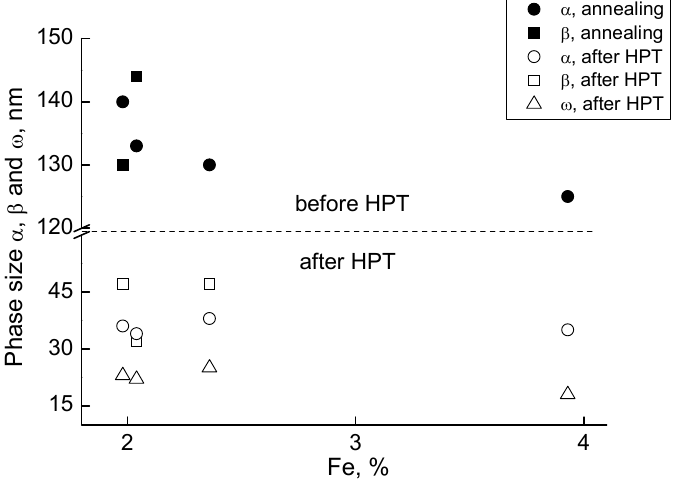
°C, 270 h, quenched and subjected to HPT at 7 GPa, 1 rpm, 5 rot. The bright field image is shown in the left-hand side of the figure, the dark field image is on the right. The grain size is about 50 nm and corresponds with the XRD data. The selected area electron dif- Figure 2. Mean grain size for the α -, β - and ω -phases in the annealed samples before and after HPT. fraction (SAED) pattern is shown as inset. It contains the rings of α- and ω-phases. Figure 2. Mean grain size for the α-, β- and ω-phases in the annealed samples before and after HPT. Table 2. Lattice parameters, phases and their volume fraction in alloys after heat treatment and HPT. Iron Con- tent, wt.%